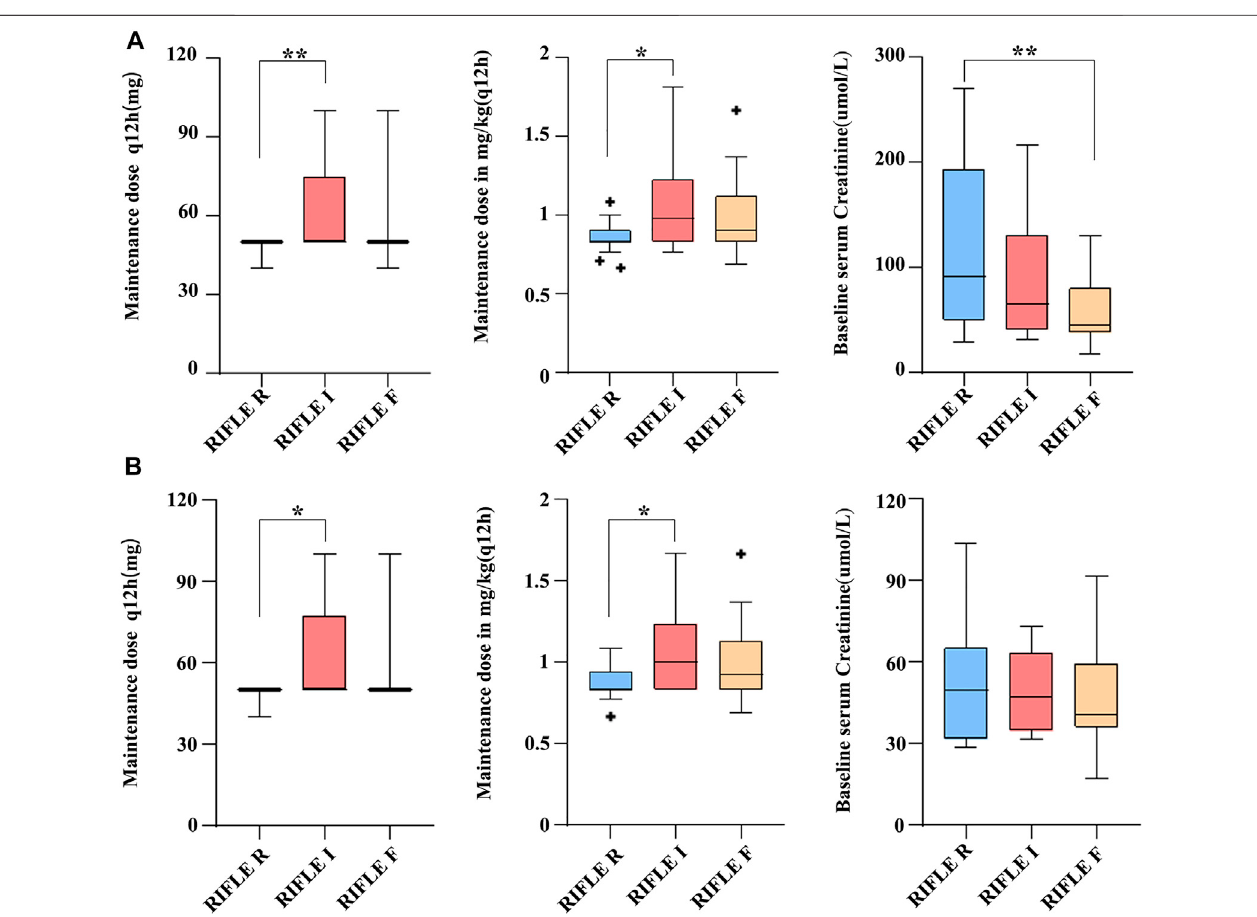
FIGURE 2 | Comparisons of baseline serum creatinine and PMB dose among patients with PMB-associated AKI according to different RIFLE stages. p p < 0.05, ** p < 0.005. (A) All patients having AKI and (B) patients having AKI with normal renal function before PMB regimen.